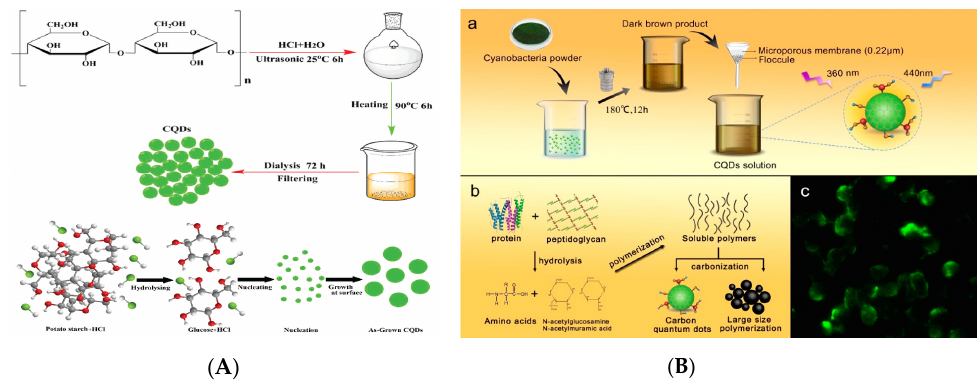
Figure 4. ( A ) Schematic of the ultrasound-assisted synthesis and the formation mechanism of CQDs. Reproduced with permission from [72]. Copyright New Journal of Chemistry, 2019; ( B ) Schematic of the hydrothermal synthesis of CQDs (a: synthesis routes of CQDs; b: formation mechanism of CQDs; c: fluorescent cell imaging). Reproduced with permission from [73]. Copyright Polymers, 2019.